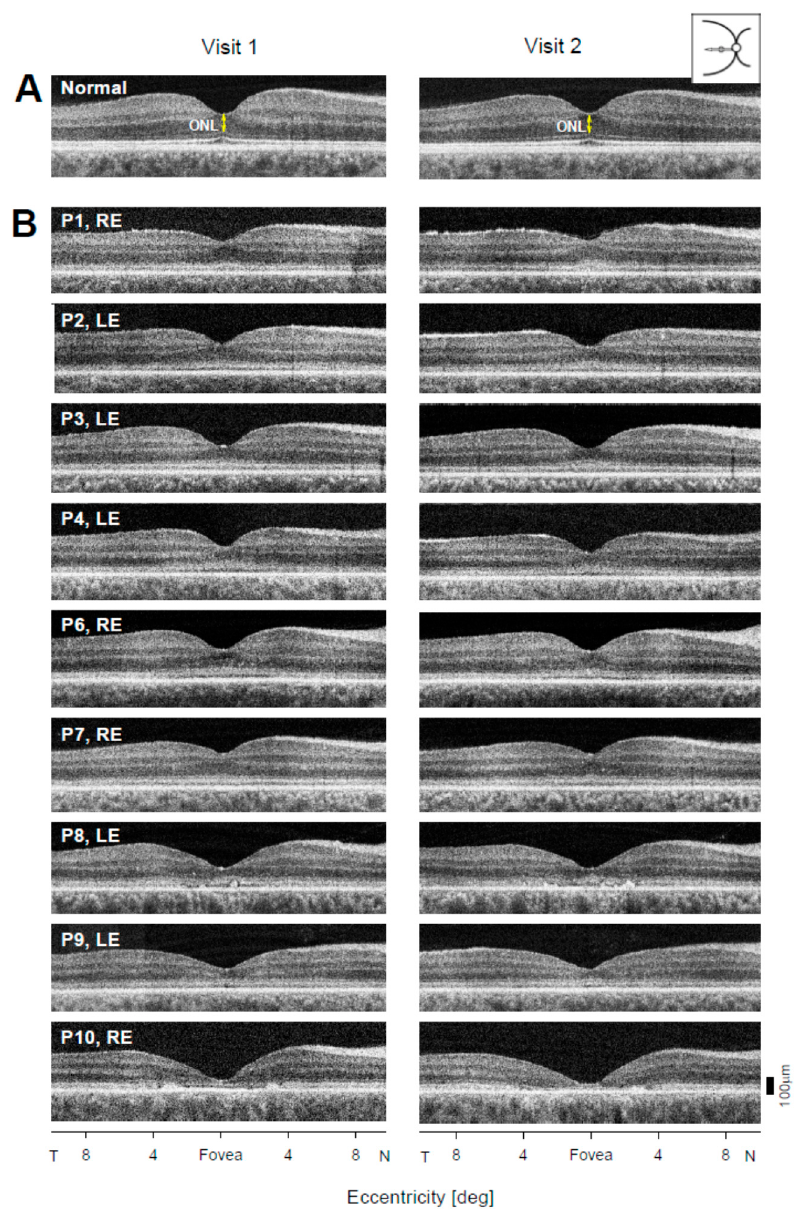
Figure 2. Central retinal optical coherence tomography (OCT) scans of GUCY2D –LCA patients at two visits. ( A ) Horizontal scans through the fovea of a normal subject at visits separated by an interval of 9 years. The foveal photoreceptor outer nuclear layer (ONL) is labeled. ( B ) Scans of nine LCA patients (P1–P4, P6–P10) on two visits separated by years, as specified in Supplementary Table S1. T, temporal; N, nasal